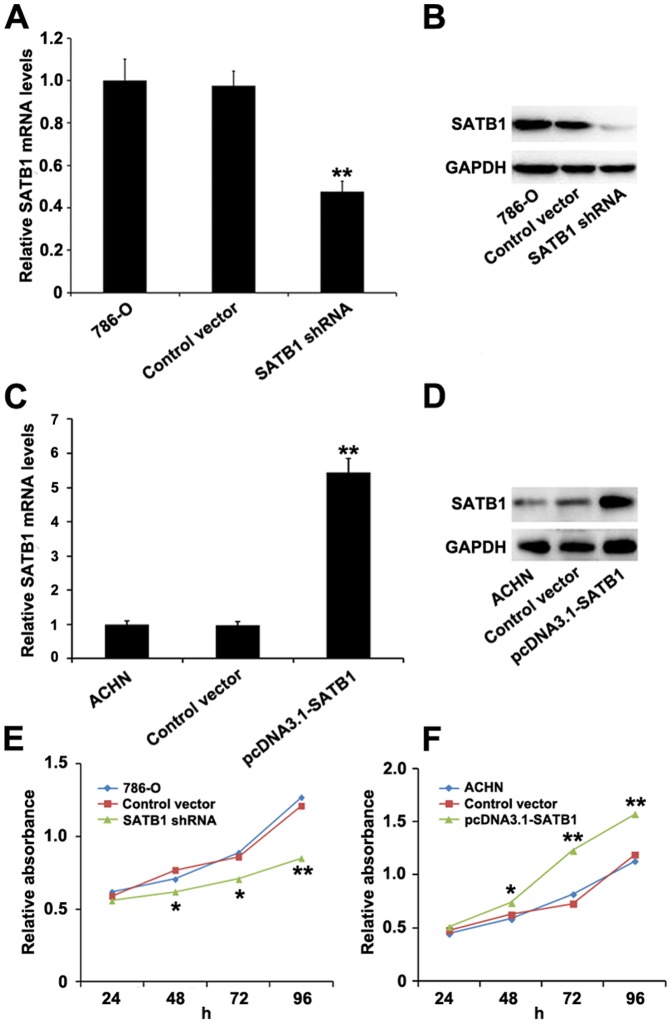
Effects of suppression and overexpression of SATB1 on RCC cell line 786-O and ACHN.The 786-O cells were transfected with pGenesil2 control vector or pGenesil2-SATB1-shRNA, while ACHN cells were treated with pcDNA3.1 control vector or pcDNA3.1-SATB1, and nontransfected 786-O and ACHN cells were used as blank controls respectively. As compared to control groups, both mRNA and protein levels of SATB1were significantly decreased in 786-O cells after SATB1 knockdown (A, B), and remarkably increased in ACHN cells with SATB1 overexpression (C, D). Evaluation of cell proliferation by CCK-8 assays showed that down-regulation of SATB1 dramatically inhibited the cell proliferation rate of 786-O cells (E), whereas overexpression of SATB1 significantly promoted the growth of ACHN cells (F). Data were shown as mean ± SD (n = 3). *P<0.05, **P<0.001.